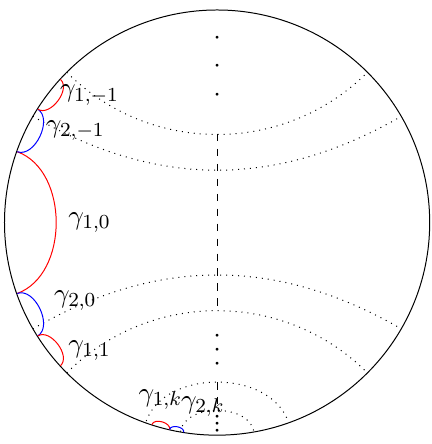
Figure 9 . RT surfaces in the AdS 3 covering space of a BTZ black hole. One RT surface in BTZ corresponds to infinitely many ones in the covering space. The dashed lines denote the